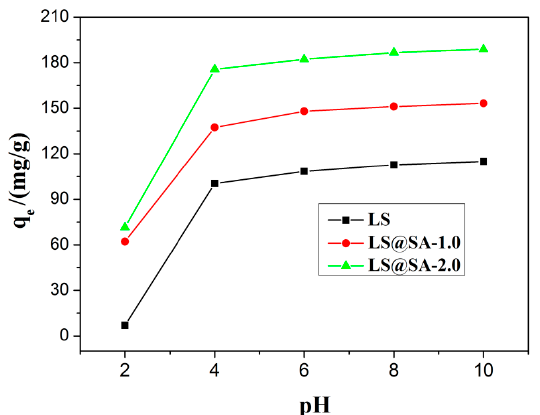
Figure 5. E ff ect of pH on the adsorption capacity of adsorbents MB. Adsorption experiments, Figure 5. Effect of pH on the adsorption capacity of adsorbents MB. Adsorption experiments, C 0 : 500 C 0 : 500 mg / L; pH range: 2.0–10; equilibrium time: 600 mg/L; pH range: 2.0–10; equilibrium time: 600 min.